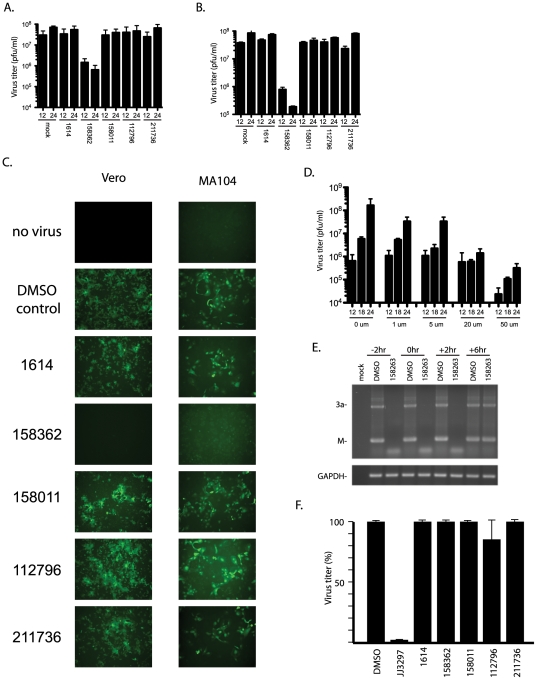
Effects of compounds on virus growth and RNA production.VeroE6 (A) or MA104 (B) cells were treated with 50 uM of each compound or 1% DMSO alone and infected with SARS-CoV(GFP) at an MOI of 3. Virus titer was assayed by plaque assay on VeroE6 cells after 12 and 24 hours of growth. C. Fluorescence images of SARS-CoV(GFP) infected Vero and MA104 cells at 24 hours post infection. D. Dose curve of NSC158362 on SARS-CoV growth. Various concentrations of drug were added to Vero cells 2 hours before SARS-CoV was added at an MOI of 3. Aliquots were removed at 12, 18 and 24 hours post infection and titered on Vero cells. E. Vero cells were treated with either DMSO or NSC 158263 at -2 hours, 0 hours, + 2 hours or +6 hours after infection with SARS-CoV. RNA was isolated at 12 hours post infection and analyzed by RT-PCR for SARS-CoV specific transcripts and GAPDH. F. MDCK cells were treated with 50 uM of each compound or 1% DMSO alone and infected with influenza A/PR/8 at an MOI of 0.1. Virus titer was determined by hemagglutination assay.